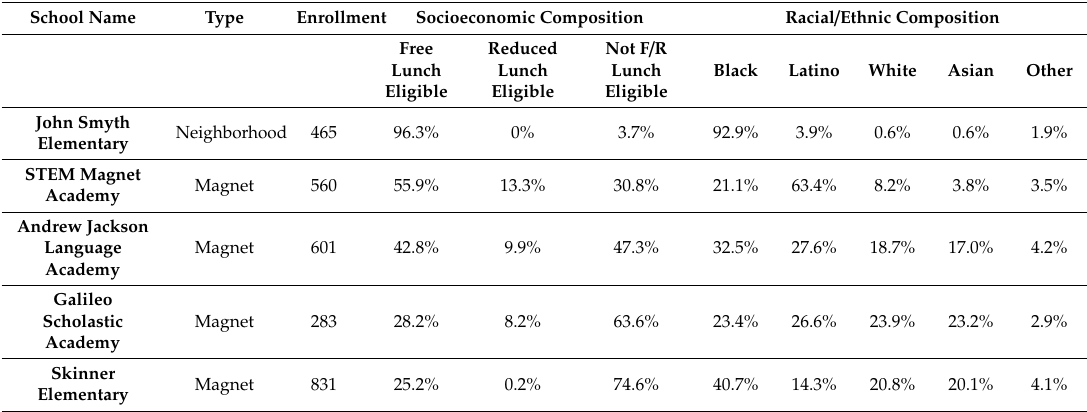
Table 3. School Characteristics, 2012–2013 Academic